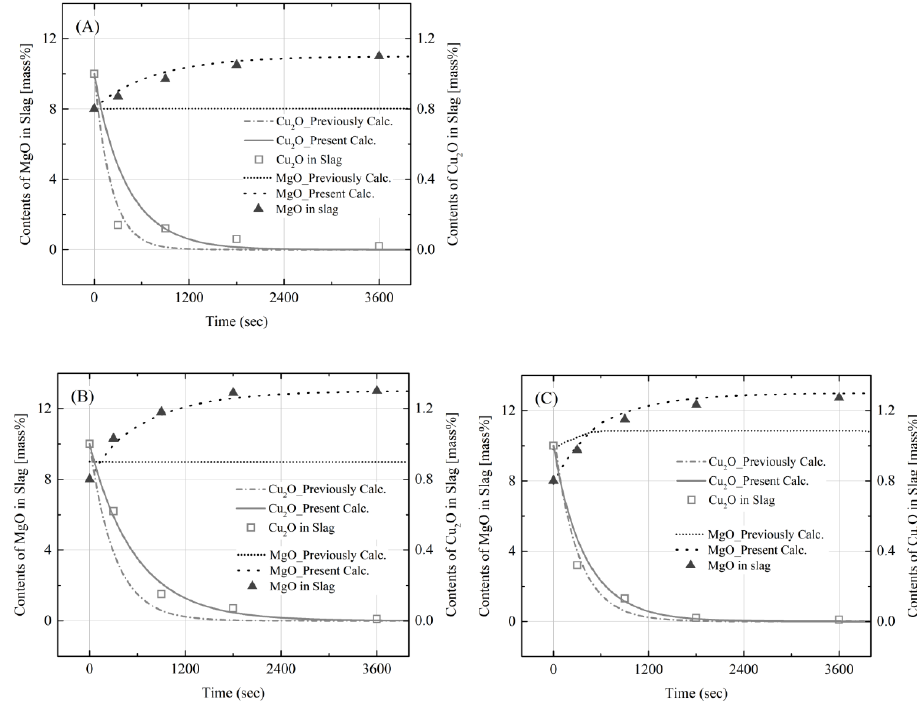
Figure 7. Comparison of the composition changes in MgO and Cu 2 O as a function of time for various slag composition by reacting with matte at 1573 K. The measured contents of MgO and Cu 2 O in ( A – C ) were the previously reported results [8]. The composition changes in MgO and Cu 2 O in ( A – C ) were simulated by the conditions of I, J, and K in Table 2, respectively.